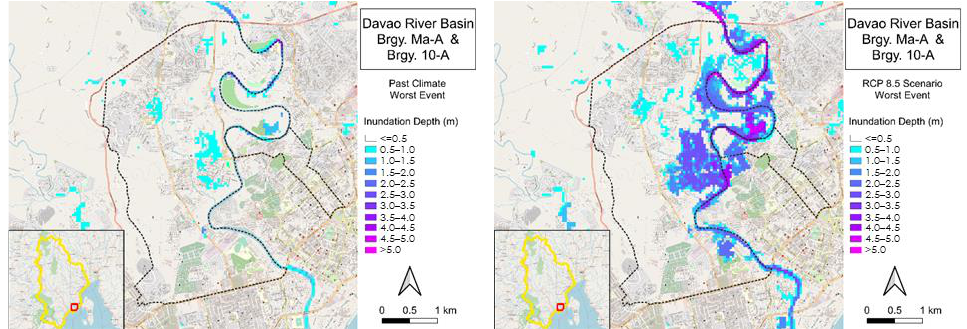
Figure 9. Barangay-scale inundation maps of the worst extreme events in past ( left ) and future ( right ) climate. The inundation extent in the future is more than 2.5 times that of the past. Table 2. Comparisons between the past and future climate from the aspects of 24 h maximum rain- fall, peak discharge, inundation extent, and inundation volume.